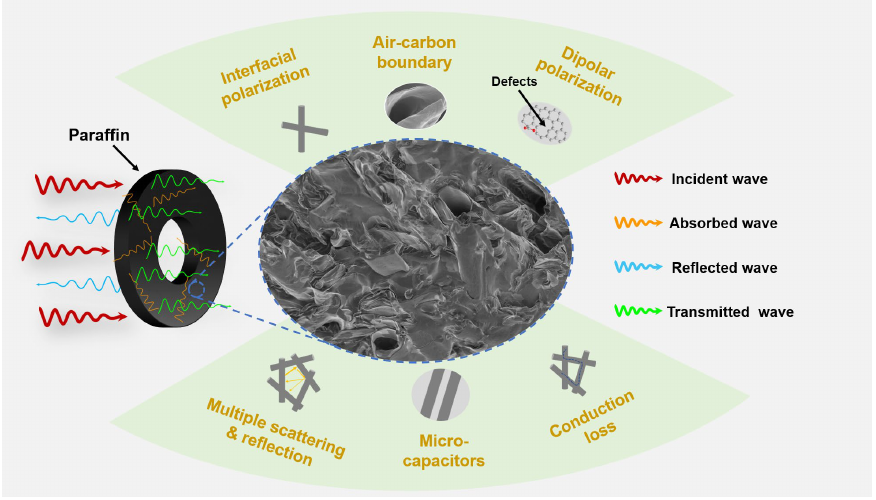
Figure 9. Schematic description of possible microwave attenuation mechanisms of 30 wt.% CKF- filled paraffin composites. paraffin